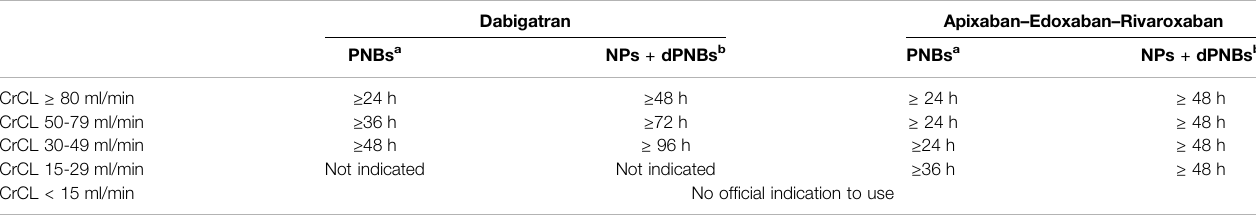
TABLE 3 | Timebetween the last dose of Direct Oral Anticoagulants (DOAC) and puncture or catheter insertion or removal. Peripheral Nerve Blocks(PNBs); NPs; (Neuraxial Procedures); Deep Peripheral Nerve Blocks (dPNBs). Dabigatran